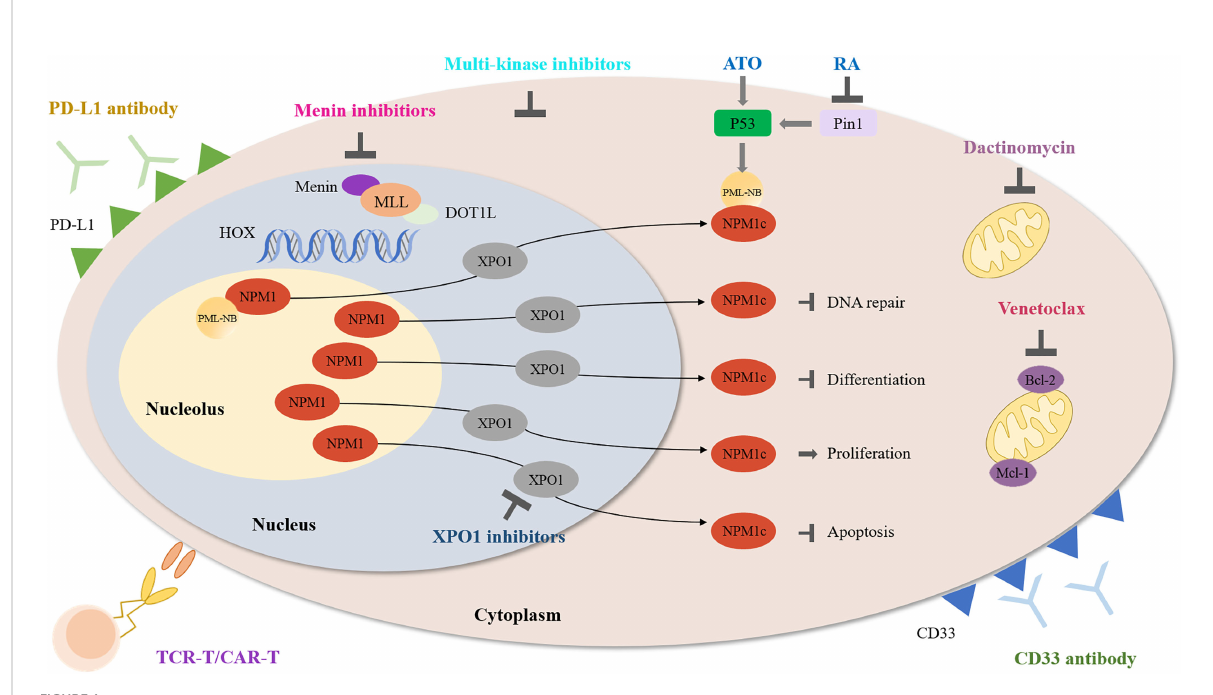
FIGURE 1 Schematic diagram describing the function of multiple agents in NPM1-mutated